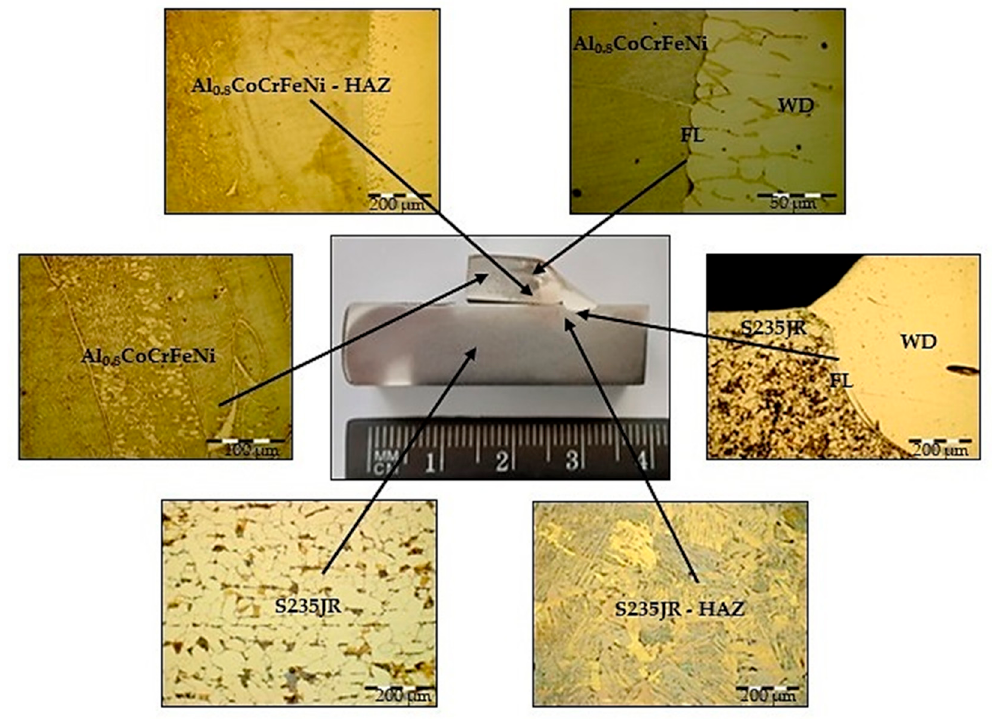
Figure 2. Optical microstructure of specific areas of the welded joint: BM—base material; HAZ— Heat-Affected Zone; FL—Fusion Line; WD—Weld Deposit.